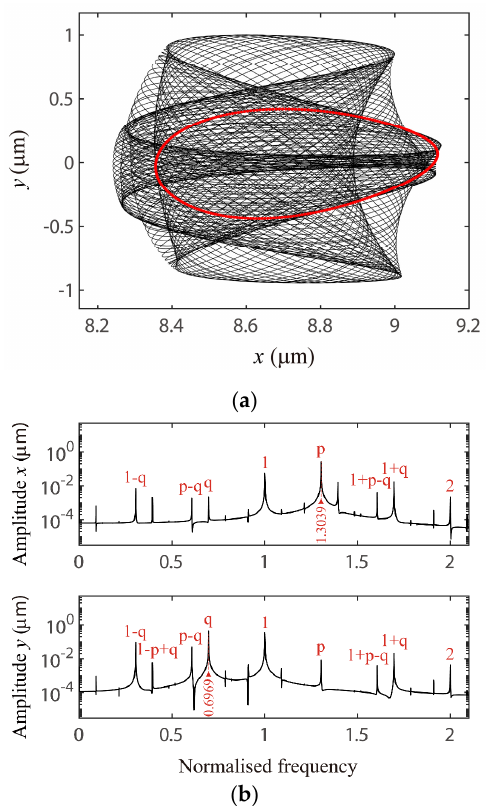
Figure 22. For δ 0 = 4.0 μ m, response characteristics of the VC quasi-period motion when Ω = 181.2 rad/s, ( a ) orbit (black line) and its Poincare mapping (red dots), ( b ) frequency spectrum.